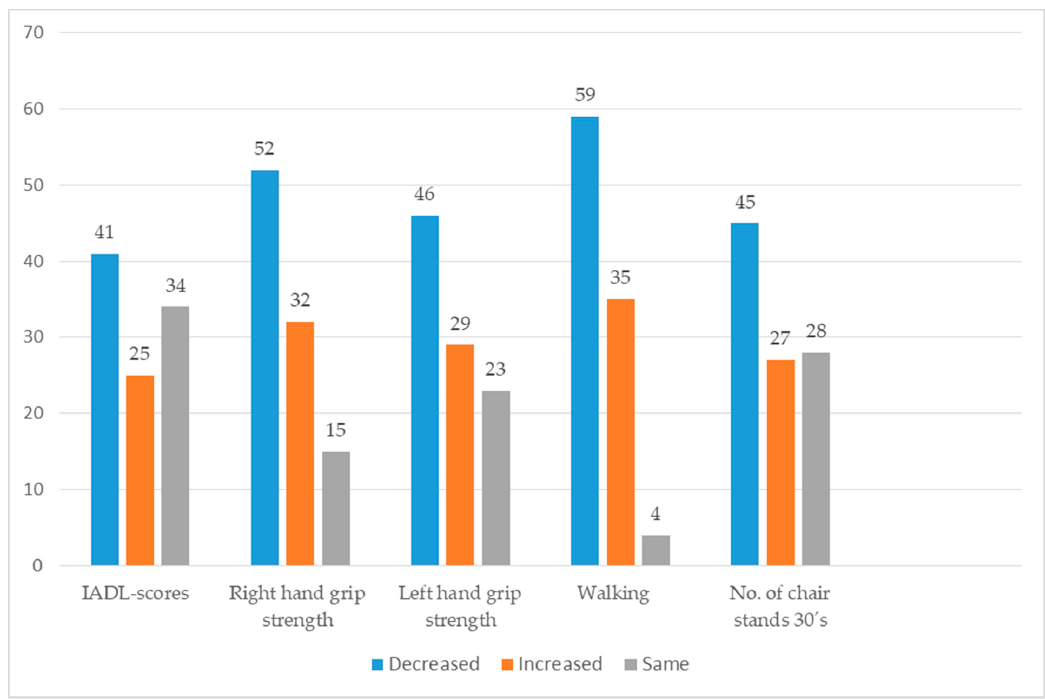
Figure 1. Frequencies (%) of participants whose physical performance parameters increased, decreased or remained the same during their first year in senior housing. IADL: instrumental activities of daily living.